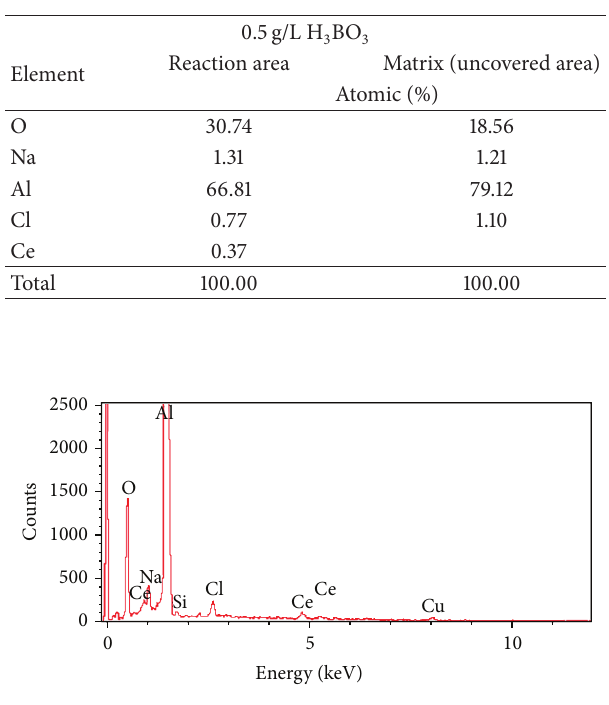
Table 2: EDS Analysis for the elements and normalized results.